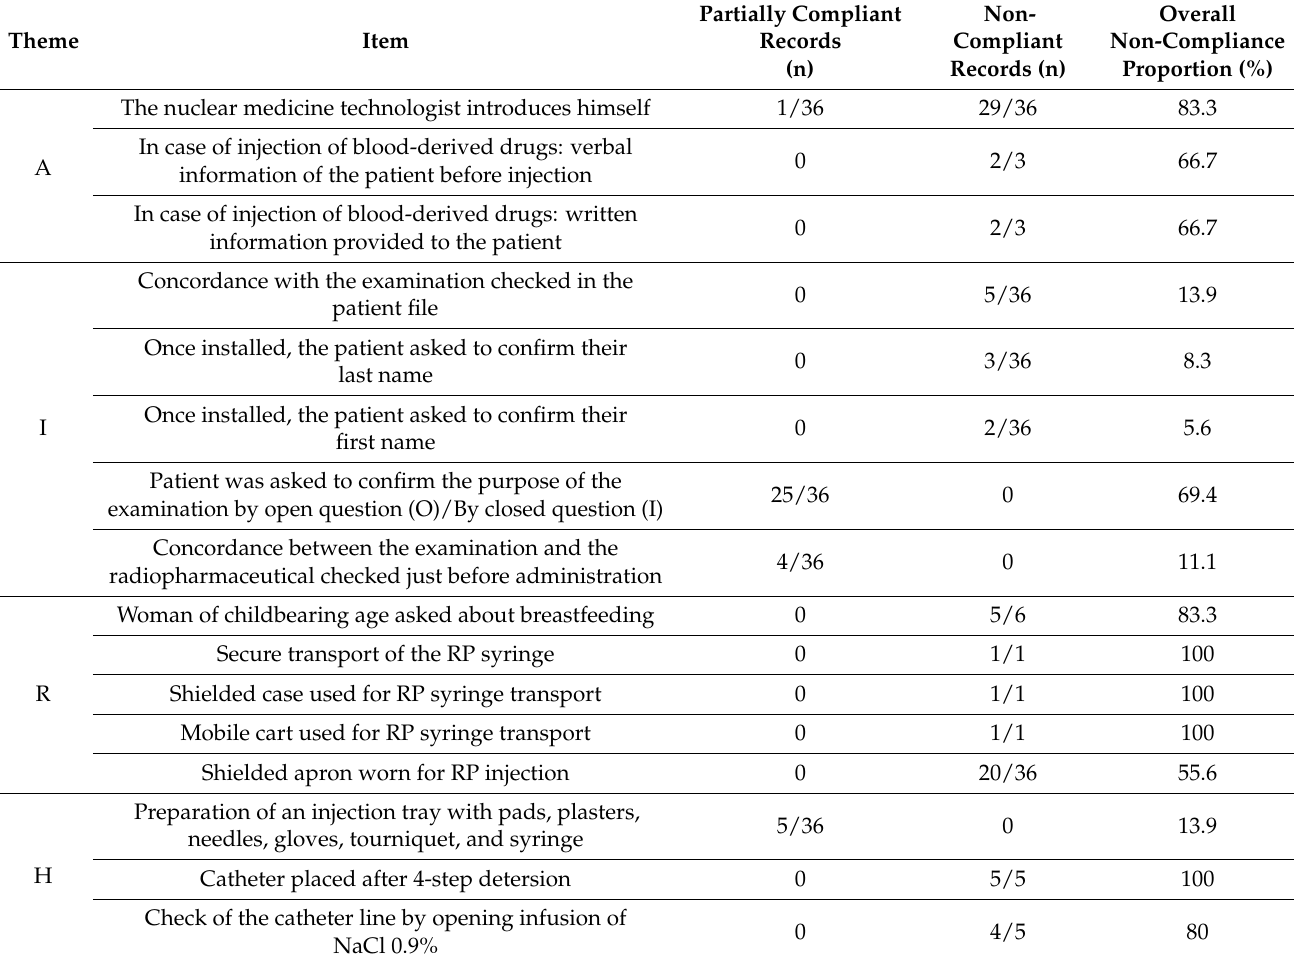
Table 2. Details of the most critical non-compliant criteria identified during the EPP